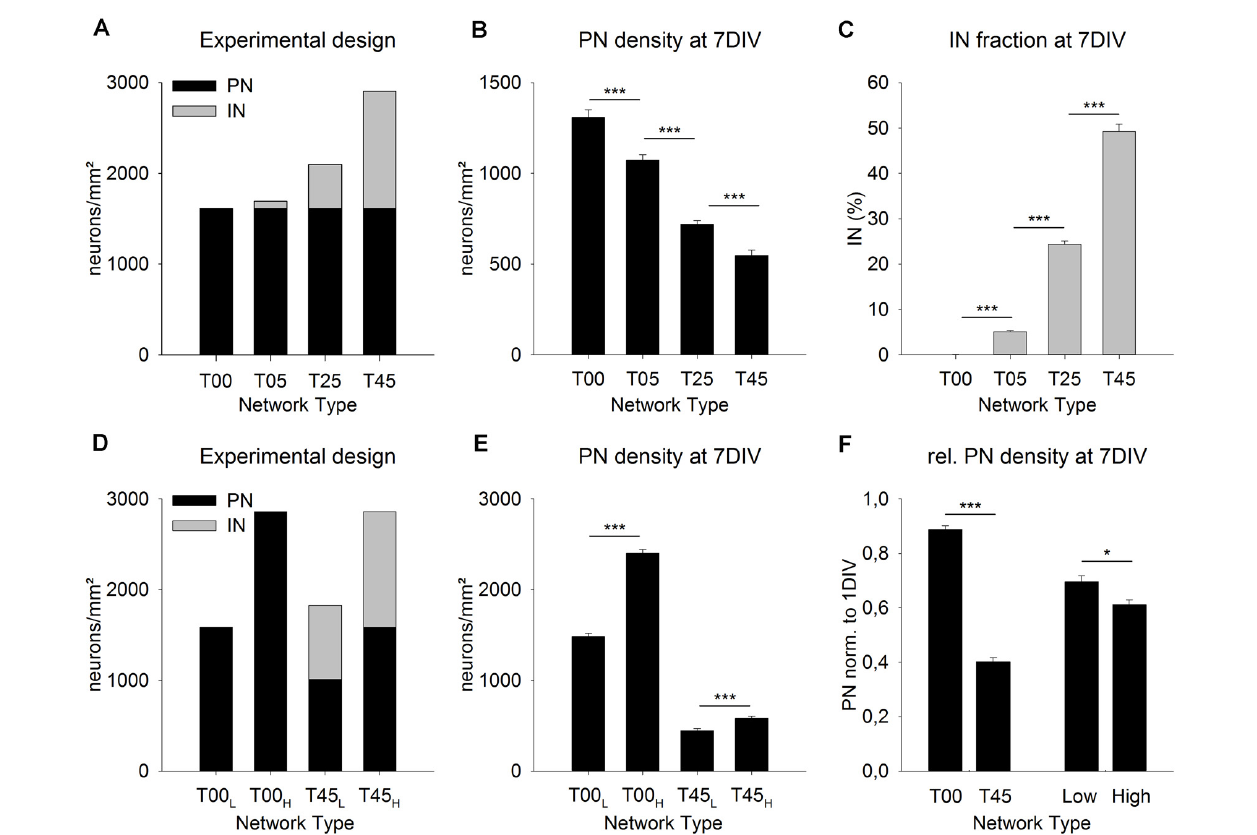
FIGURE 3 | MGE-INs modulate the density of PNs during the 1st week in vitro . Networks with increasing MGE-IN content were generated by plating dissociated MGE-INs ( A , gray bars, 1 DIV) on cortical networks with the same density of PNs ( A , black bars). After 7 DIV the projection neurons (PN) density was highest in T00 and lowest in T45 networks (B) . The PN/IN ratio did not change during the 1st week in vitro (C) . (D) Network pairs with no MGE-INs (T00) or high MGE-IN content (T45) were generated with low (L) or high (H) total cell density. (E) The much higher loss of PNs in T45 L and T45 H networks showed that PN density during the 1st week was predominantly dependent on IN density rather than on total cell density. (F) For statistical comparison, the data was normalized to 1 DIV values and pooled in four groups (see “Results” Section). This analysis showed that the presence of INs (T00 vs. T45) had a larger effect on PN density decline than total cell density (Low vs. High). Asterisks show the level of statistical significance (* P ≤ 0.05, *** P ≤